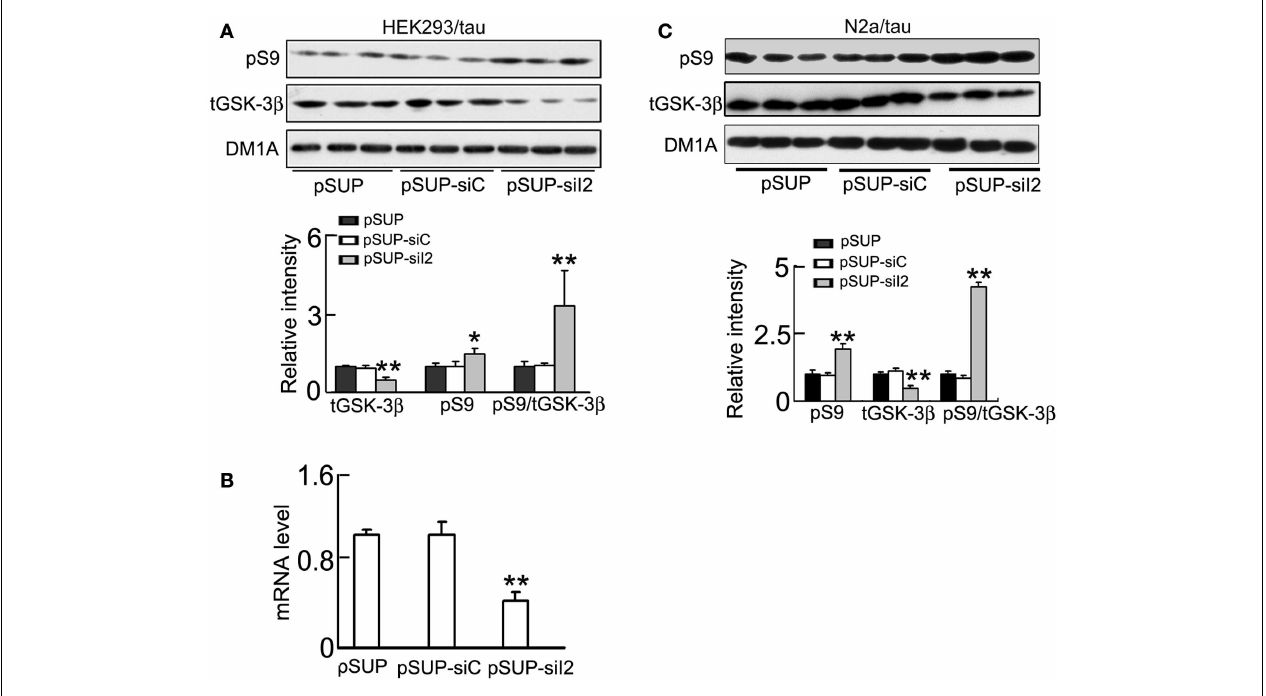
estimated byWestern blotting normalized against DM1A. (B) The mRNA level of GSK-3 β was analyzed by real-time PCR, normalized against GADPH and expressed by setting pSUP as 1.The data were presented as mean ± SD of three independent experiments. * p < 0.05; ** p < 0.01 vs.